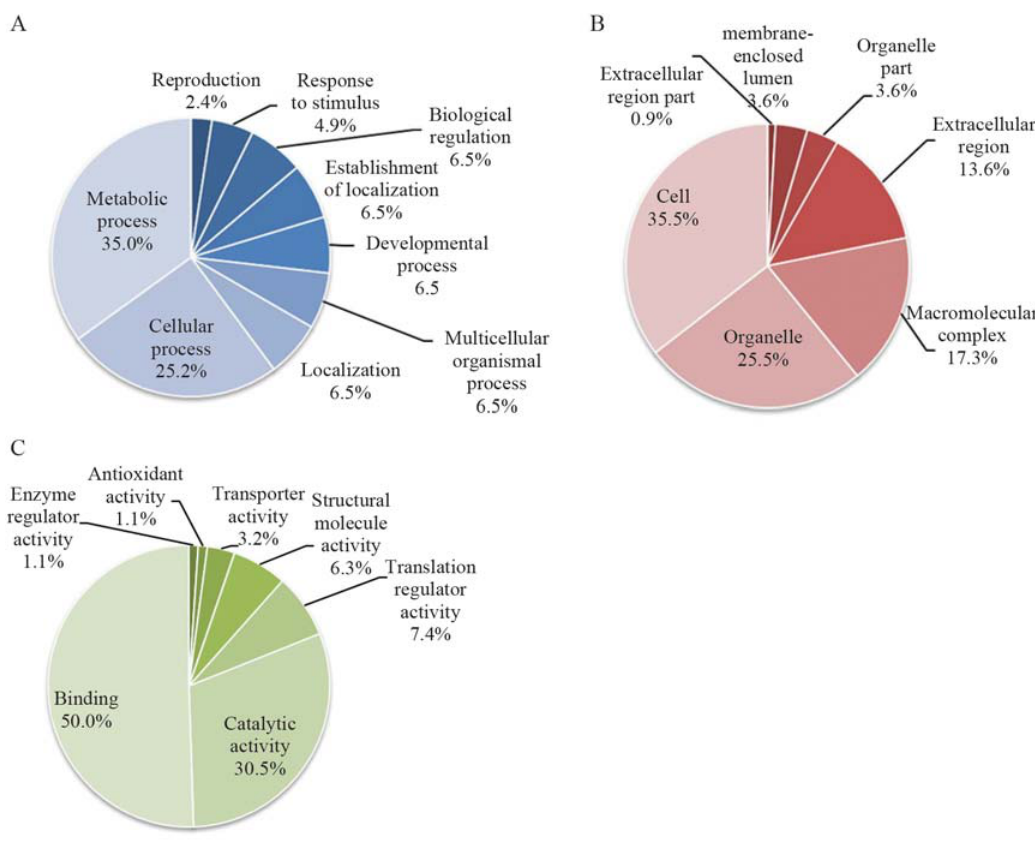
Figure 1 - The percent distribution of nucleotide sequences in the SSH ovarian cDNA library of P. monodon according to three principal GO categories: A, biological process; B, cellular components and C, molecular functions,